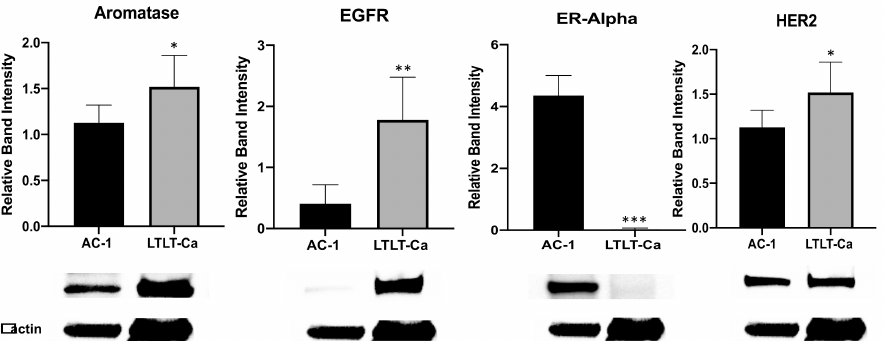
Figure 1. Comparative protein expression profile of letrozole-sensitive cells (AC-1) versus letrozole- resistant cells (LTLT-Ca). The AC-1 and LTLT-Ca cells were assayed by immunoblot with antibodies directed against aromatase, EGFR, ER α , or HER2. β actin was measured as an internal loading control. Quantitative analysis represents the band intensity of the indicated proteins after normalizing to β actin loading control. One-way ANOVA analyses were performed, and AC-1 cells were compared to LTLT-Ca cells. Results are expressed as the mean relative band intensity ± SD (*** p < 0.001, ** p < 0.01, * p < 0.05), and data are representative from one of at least three independent